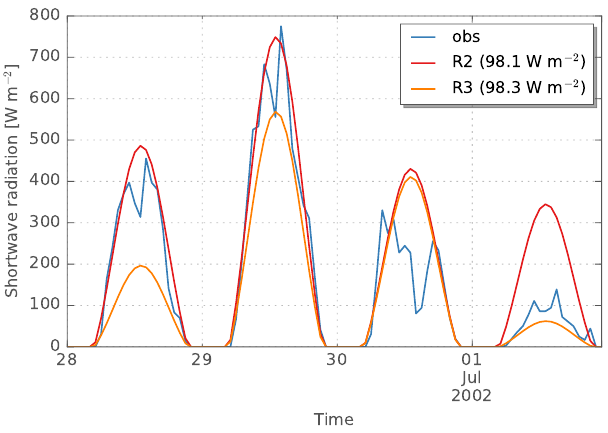
Figure 6. Example application of the radiation disaggregation model R2 and R3 for De Bilt. Observed and disaggregated time series are shown for shortwave radiation. Option R2 is based on sunshine duration, whereas option R3 requires minimum and maxi- mum temperature as input. The numbers in parentheses indicate the root mean square error (RMSE) computed for each